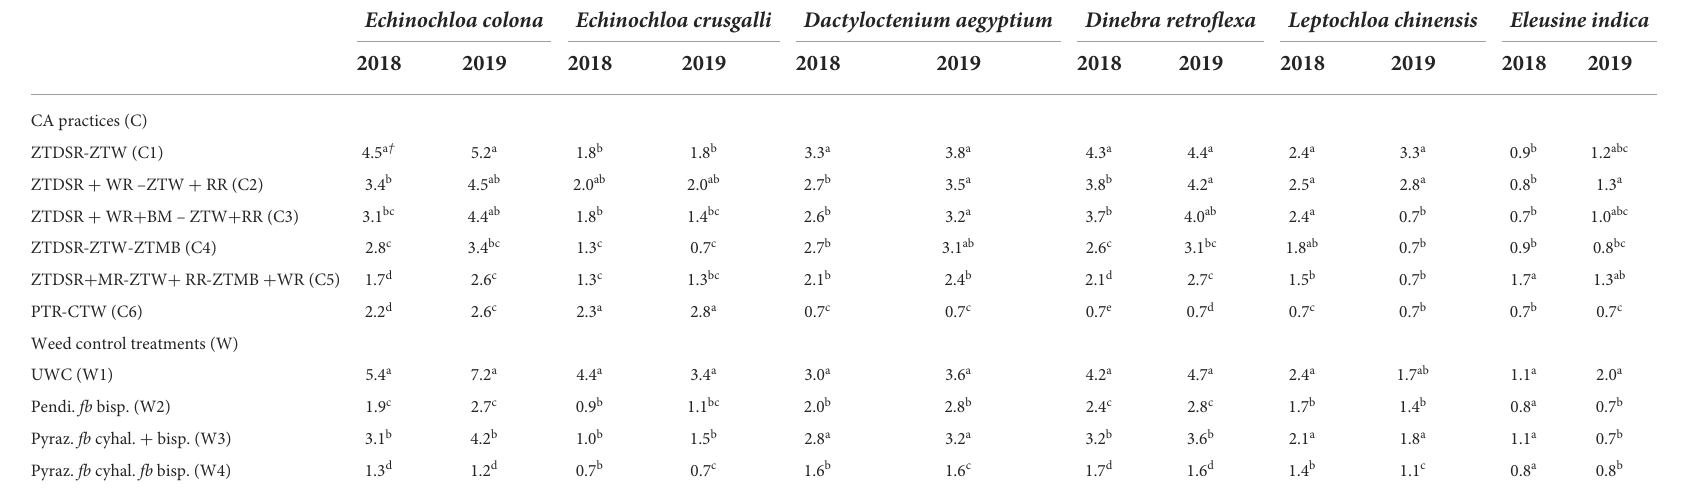
TABLE 4 Species-wise grassy weeds density (no. m − 2 ) in rice as influenced by CA and weed control treatments at 60 DAS/DAT during 2018 and 2019. Treatment Grassy weeds density (no. m − 2 ) ‡